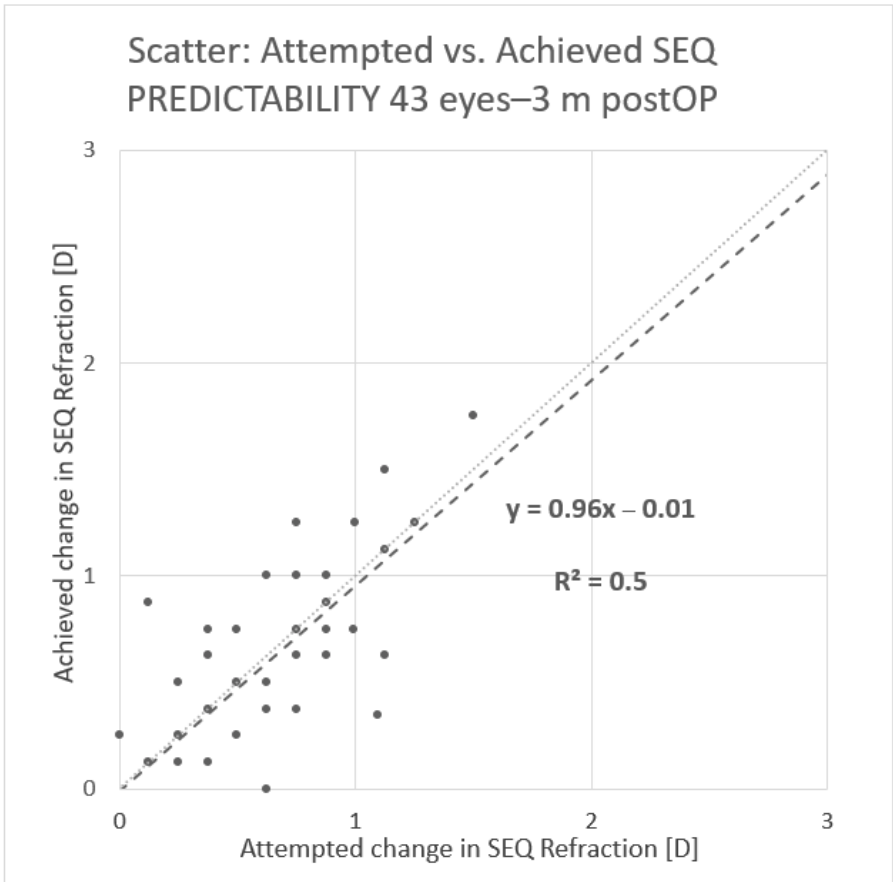
Figure 1. Histogram of predictability. Scatter of the attempted versus achieved spherical equivalents 3 months after the Transepithelial Photorefractive Keratectomy (TransPRK).